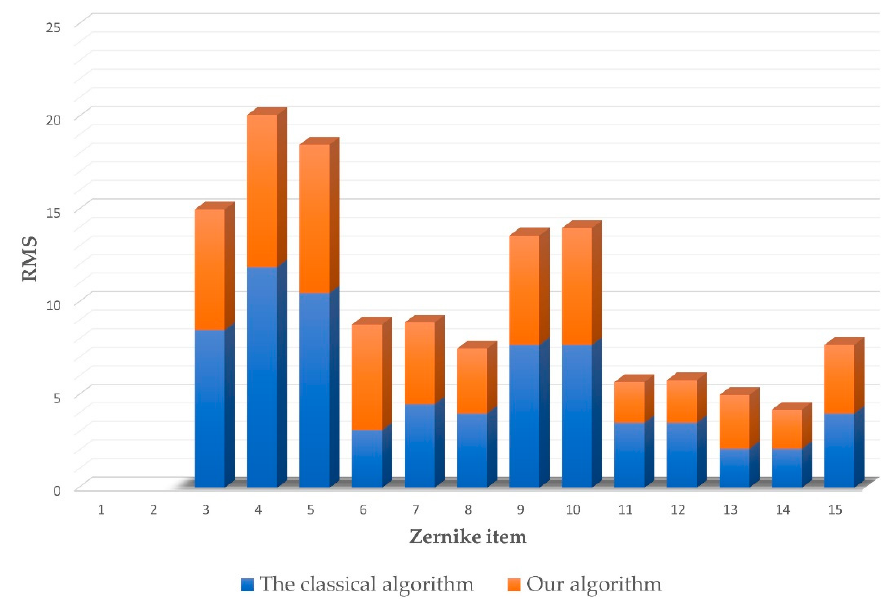
Figure 9. The dynamic range of the algorithms.